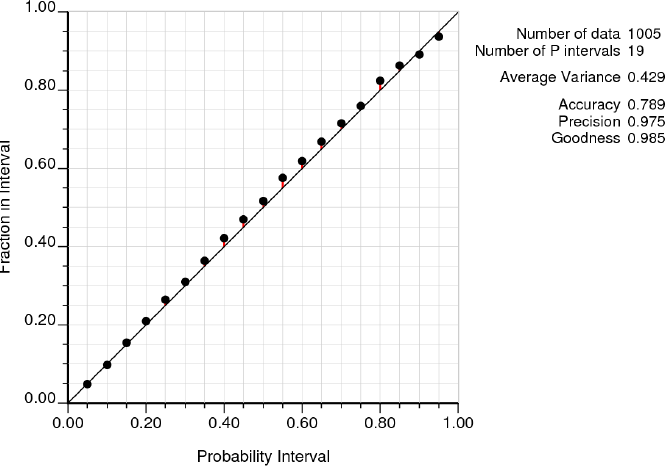
Figure 11. ( a ) Cumulative curve for 100 realizations compared to the original data and ( b ) variograms for 20 realizations compared to the original data.